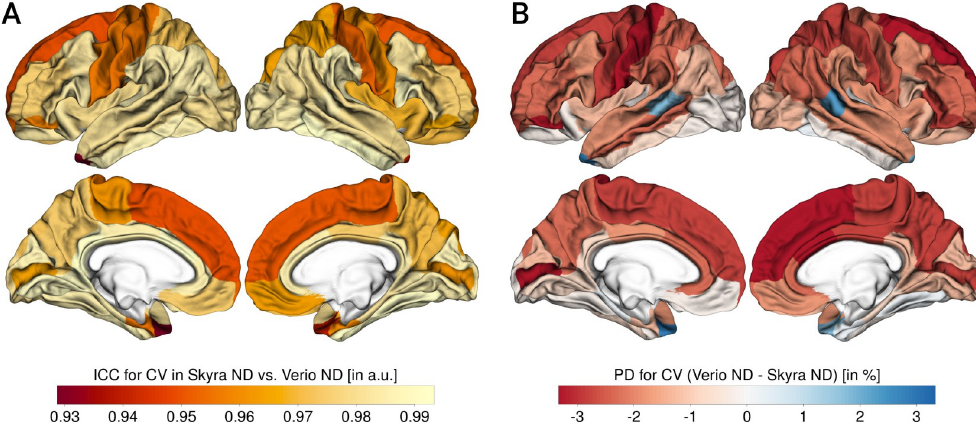
Fig 4. Reliability and percent differences for cortical volume (CV). A: CV ICC, B: CV PD (for each panel, left column shows lateral and medial view of left hemisphere, right column shows lateral and medial view of right hemisphere), negative values:Skyra > Verio, positive values: Verio > Skyra.